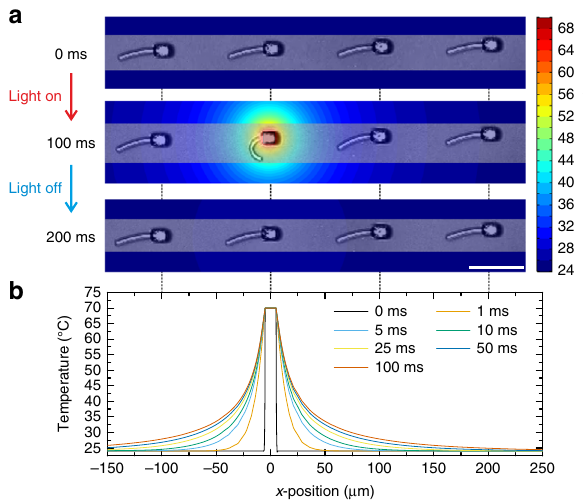
Fig. 5 Light-induced actuation. a Upon focusing a femtosecond laser on one of the bases, the corresponding bi-material beam bends strongly, whereas the adjacent structures show only a weak response. Upon switching off the light, the structure moves back to its original position. This behavior is repeatable. A calculated temperature pro fi le (see false-color scale on the right) is overlaid onto the measured optical micrographs. b Cross-sections through such temperature pro fi les in the water bath. At t = 0 a constant temperature is assumed for the base, whereas the outside stays at ambient conditions. With increasing time (see legend) heat diffuses away from the base, however, the temperature rise at the adjacent structures is too small for signi fi cant actuation (compare Fig. 3b). Scale bar is 50 µ